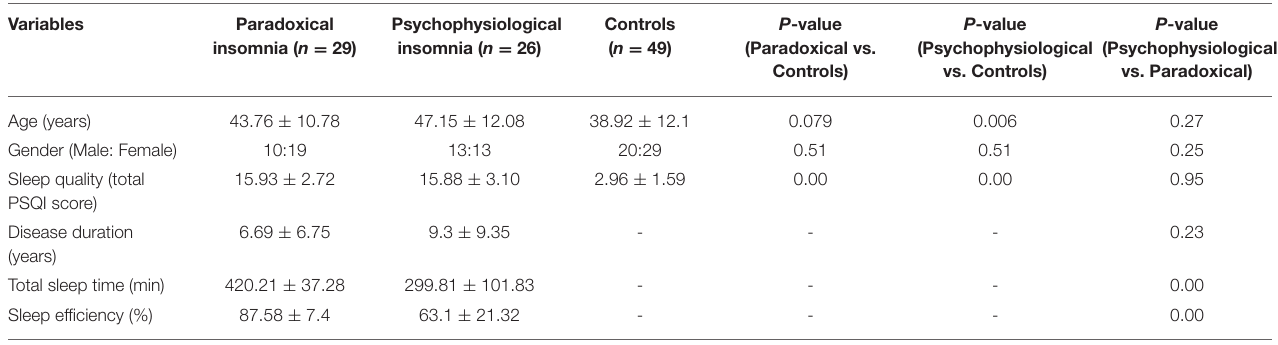
TABLE 1 | Demographics and clinical characteristics of all